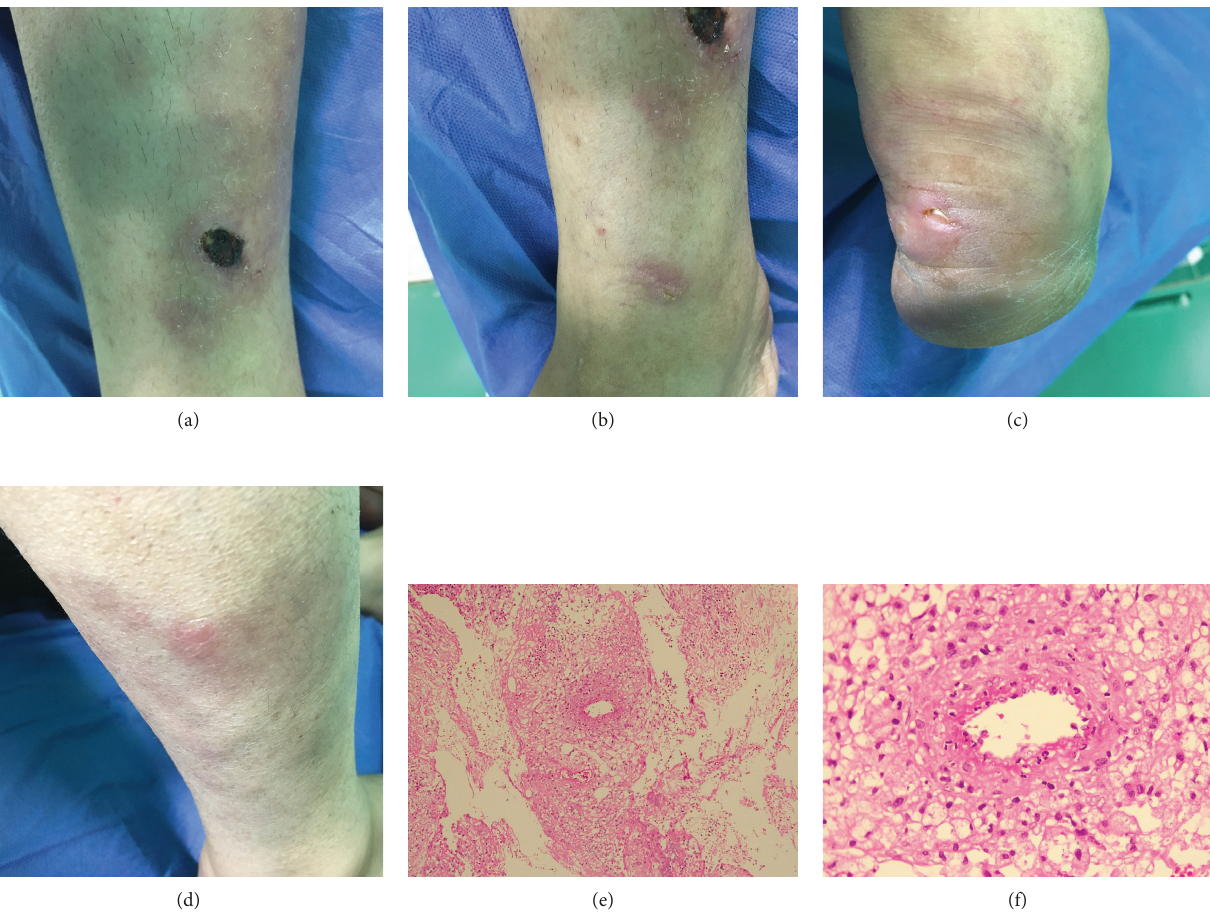
Figure 1: (a to d) Large, warm, erythematous, nontender plaques and subcutaneous nodules on the edematous right leg and ankle in a renal transplant recipient on admission. (e and f) Hematoxylin and eosin shows fat necrosis and coagulative necrosis and rare foci of vasculitis as well as foci of RBC